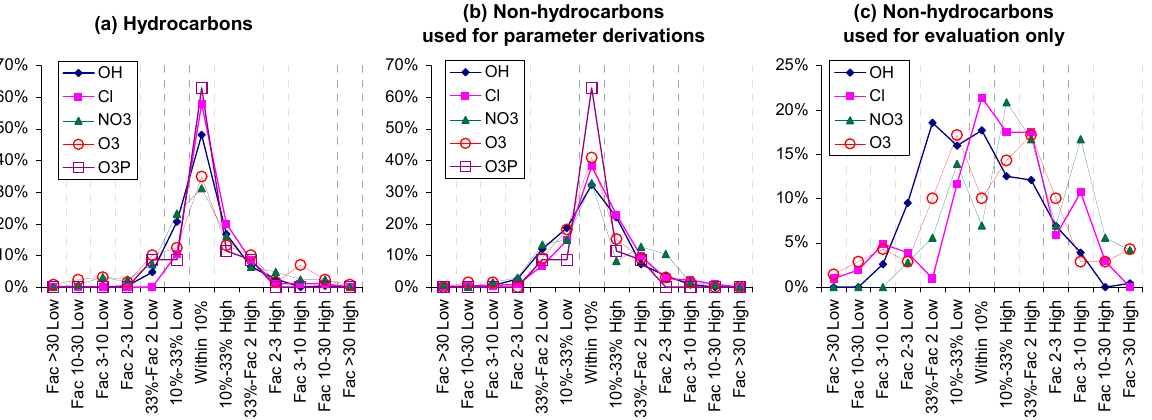
Figure 2. Distribution plots of factor errors in rate constant in estimates at 298 K. Rate constants for ( a ) hydrocarbons, ( b ) non-hydrocarbons used to derive parameters, and ( c ) non-hydrocarbons used for evaluation only.